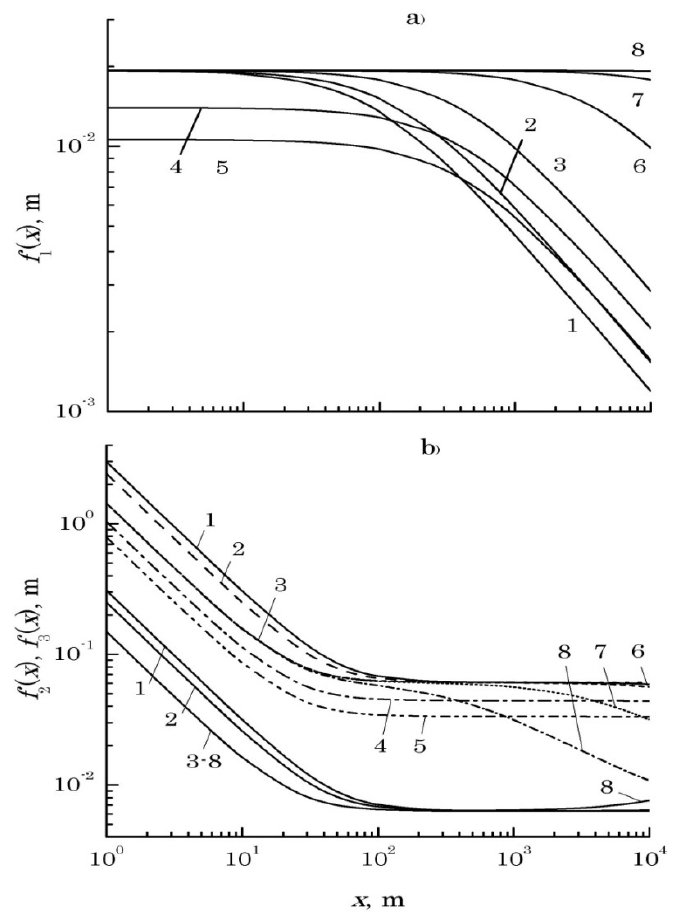
Figure 2. Nomograms used for the selection of initial values of laser beam parameters and ( x ) for a choice of initial values of beams radiuses: spacing of their optical axes: function f 1 ( x ) and f ( x ) for a choice of size of spatial diversion their optical curves 1–8 ( a ); functions f 2 3 ( x )–the bottom group of solid curves 1–8; f ( x )–the top group of curves of axes ( b ): f 2 3 different linestyles